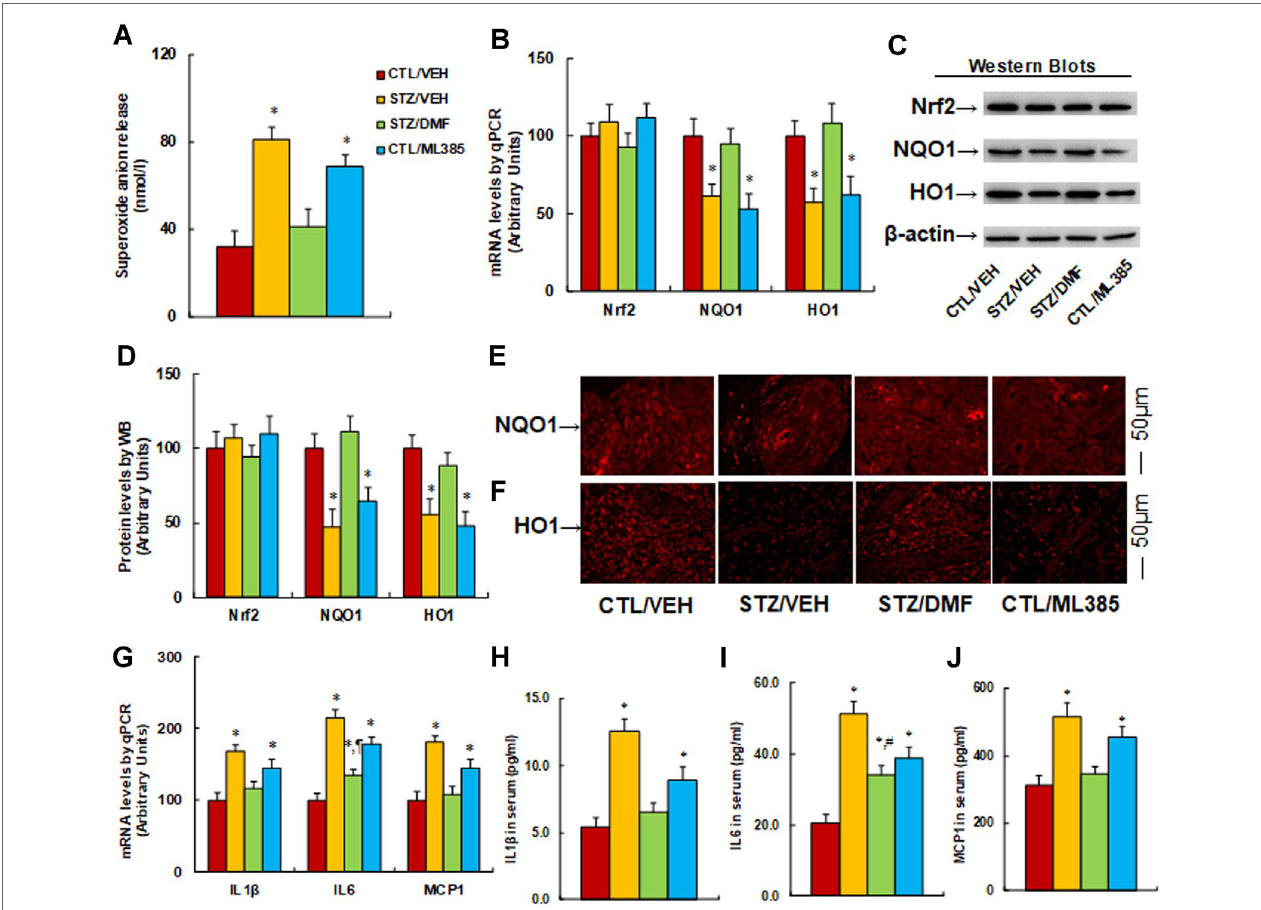
FIGURE 5 | Activation of Nrf2 prevents diabetes-induced oxidative stress and expression of proinflammatory cytokines in rats. The burn injuries were introduced, and the experimental rats were divided into four groups: control rats (CTL/VEH), STZ diabetic rats (STZ/VEH), STZ rats treated by 15 mg/kg/d of DMF (STZ/DMF), or CTL rats received 15 mg/kg/d of ML385 (CTL/ML385). The wounds were excised and collected from the experimental rats for further analysis. (A) Superoxide anion release, n = 5. (B) mRNA levels for Nrf2 and its target genes by qPCR, n = 4. (C) Representative pictures for Western blots. (D) Protein quantitation for (C) , n = 4. (E) Representative pictures for NQO1 expression by immunohistochemistry. (F) Representative pictures for HO1 expression by immunohistochemistry. (G) mRNA levels for proinflammatory cytokines, n = 4. (H) IL1 β in serum, n = 5. (I) IL6 in serum, n = 5. (J) MCP1 in serum, n = 5. * P < 0.05, vs CTL group; ¶ P < 0.05, vs STZ/ VEH group. Data were expressed as mean ±